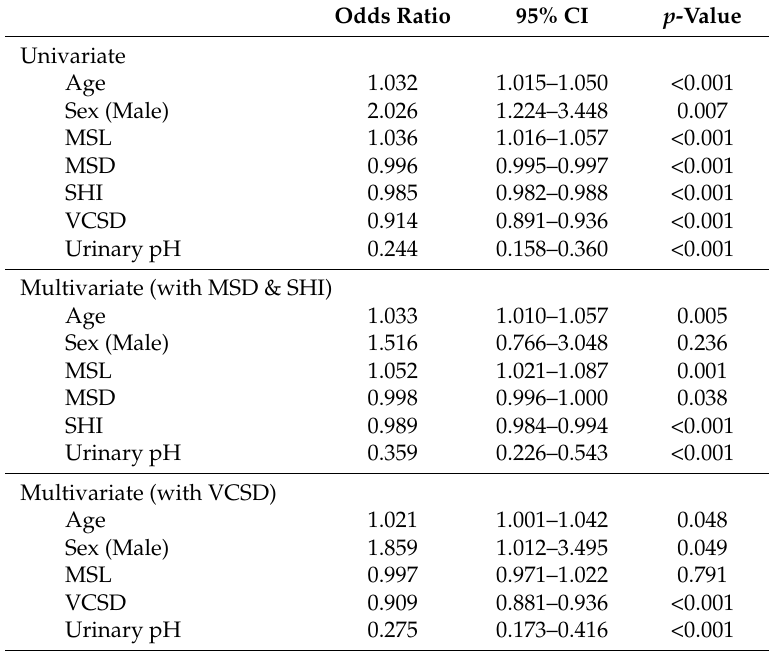
Table 2. Logistic regression models for predicting uric acid stones shown by test parameters.